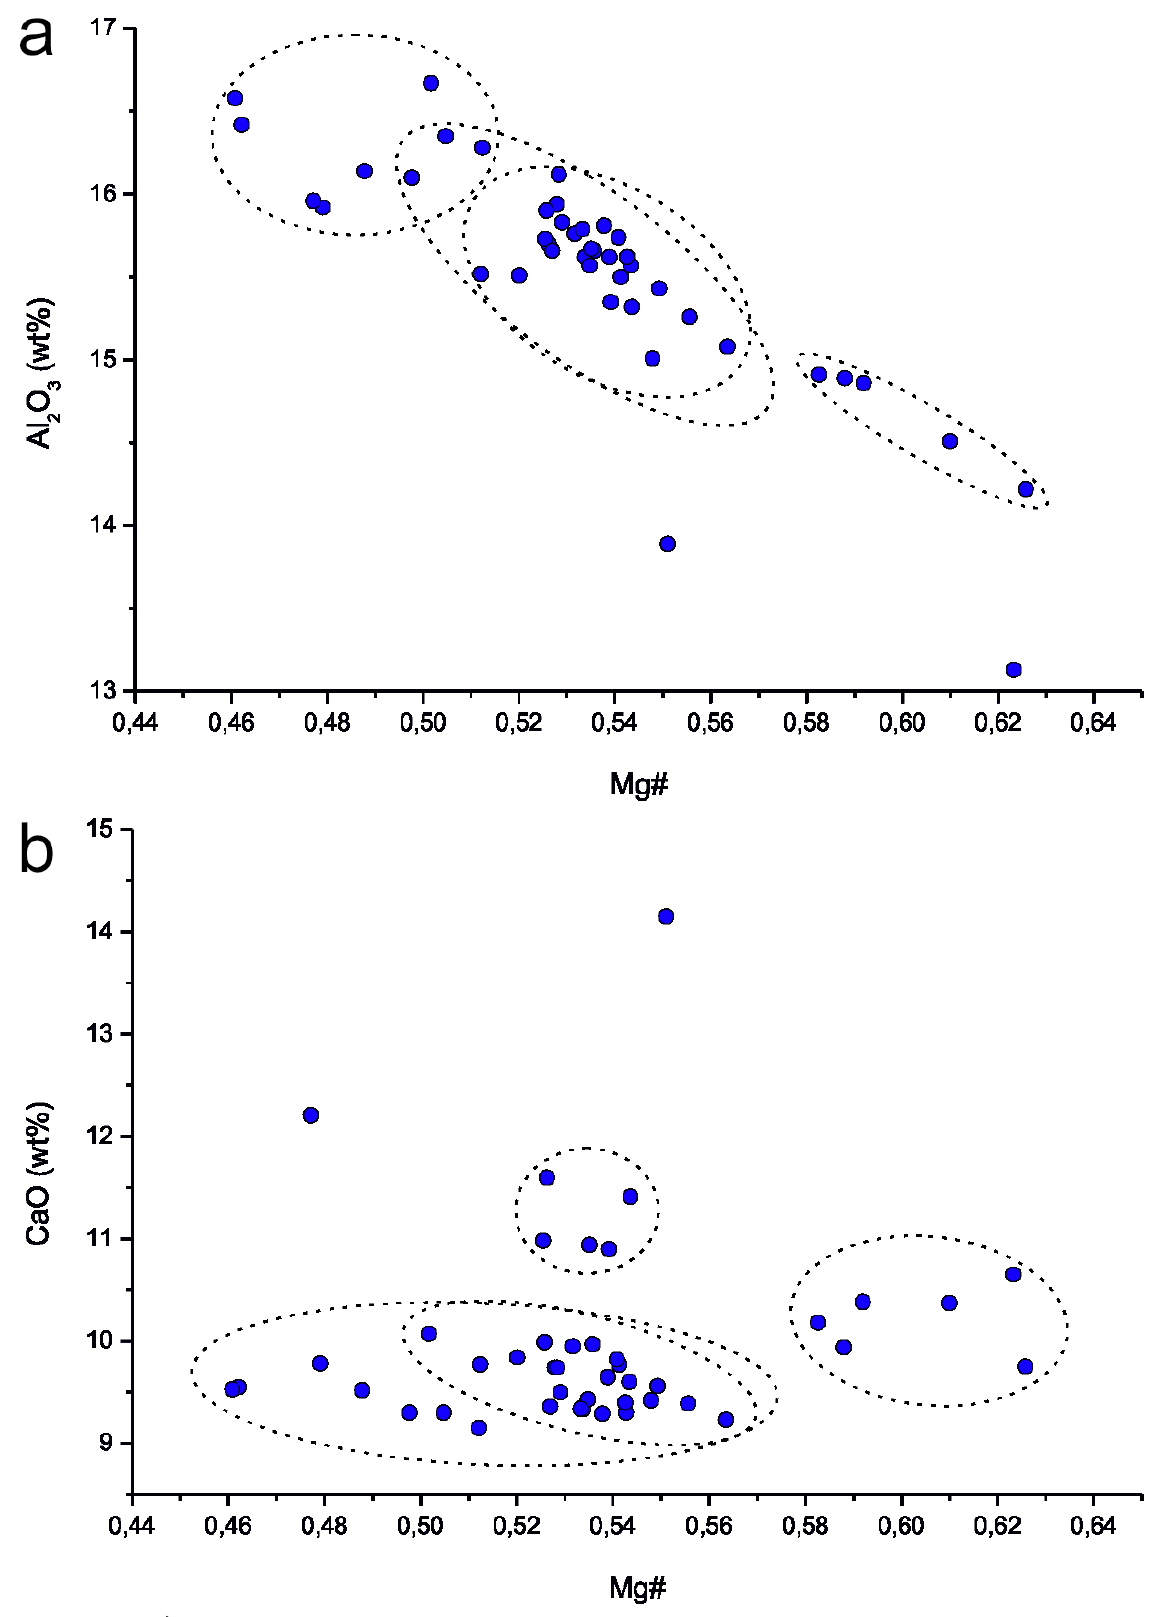
Figure 3. a) Magnesium-number Mg# versus Al2O3 and Mg# versus CaO, with Mg# = (MgO/40.32)/[(MgO/40.32+Fe2O3(t)∙0.9/79.8)] (Harvey et al. 2006). The stippled lines indicate possible